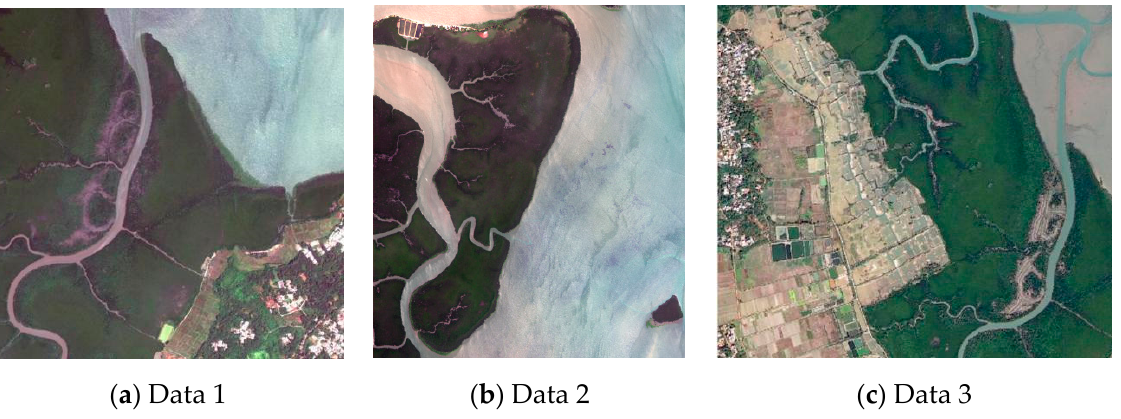
Figure 12. Remote sensing image used in the experiment.